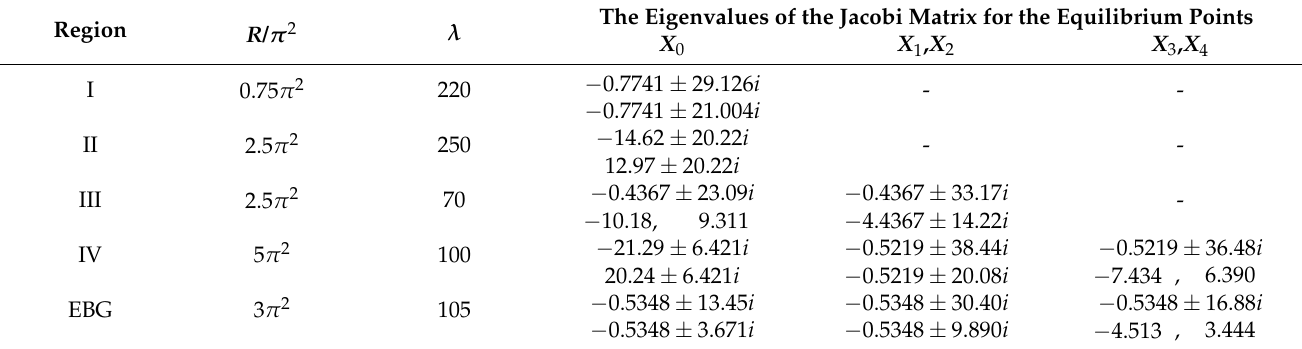
Table 2. The eigenvalues of the Jacobi matrix at the equilibrium point in each region. The Eigenvalues of the Jacobi Matrix for the Equilibrium Points Region R / π 2 λ X 0 X 1 , X 2 X 3 , X